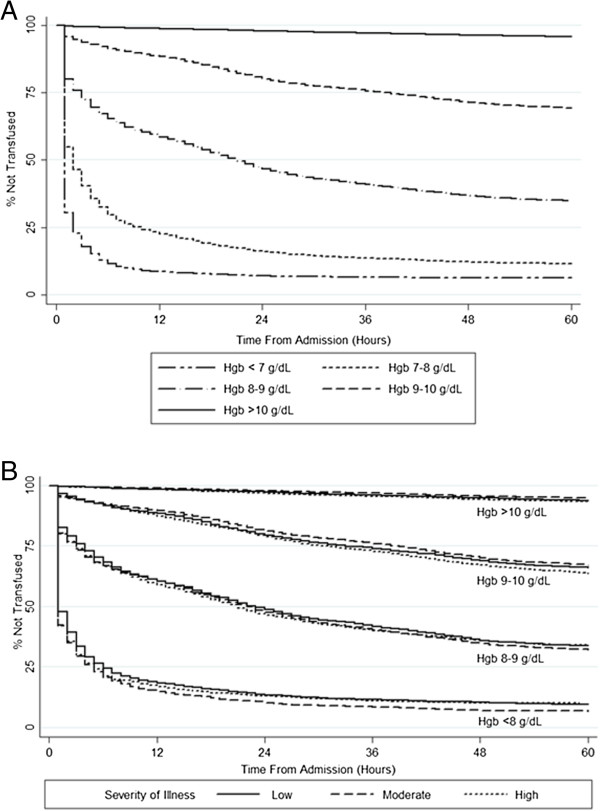
Probability of Red Blood Cell Transfusion as a Function of Admission Hemoglobin and Severity of Illness. A) The left panel shows that the likelihood of transfusion is tightly linked to the degree of anemia and that it falls exponentially in the first 24 hours, after which the rate of decrease is linear. B) The right panel shows that trends in severity of illness, within varying strata of admission hemoglobin, do not explain differences in overall rates of RBC transfusion. Severity of Illness refers to ranges of Laboratory Acute Physiology Score, version 2 (LAPS2) a physiology-based score which includes vital signs, neurological status, and laboratory results [19]. Increasing degrees of physiologic derangement are reflected in a higher LAPS2. Ranges of Severity of Illness (LAPS2) were defined as: Low (0-75), Moderate (75-125), and High (>125), associated with 30-day mortality rates of 2%, 9%, and 30%, respectively.